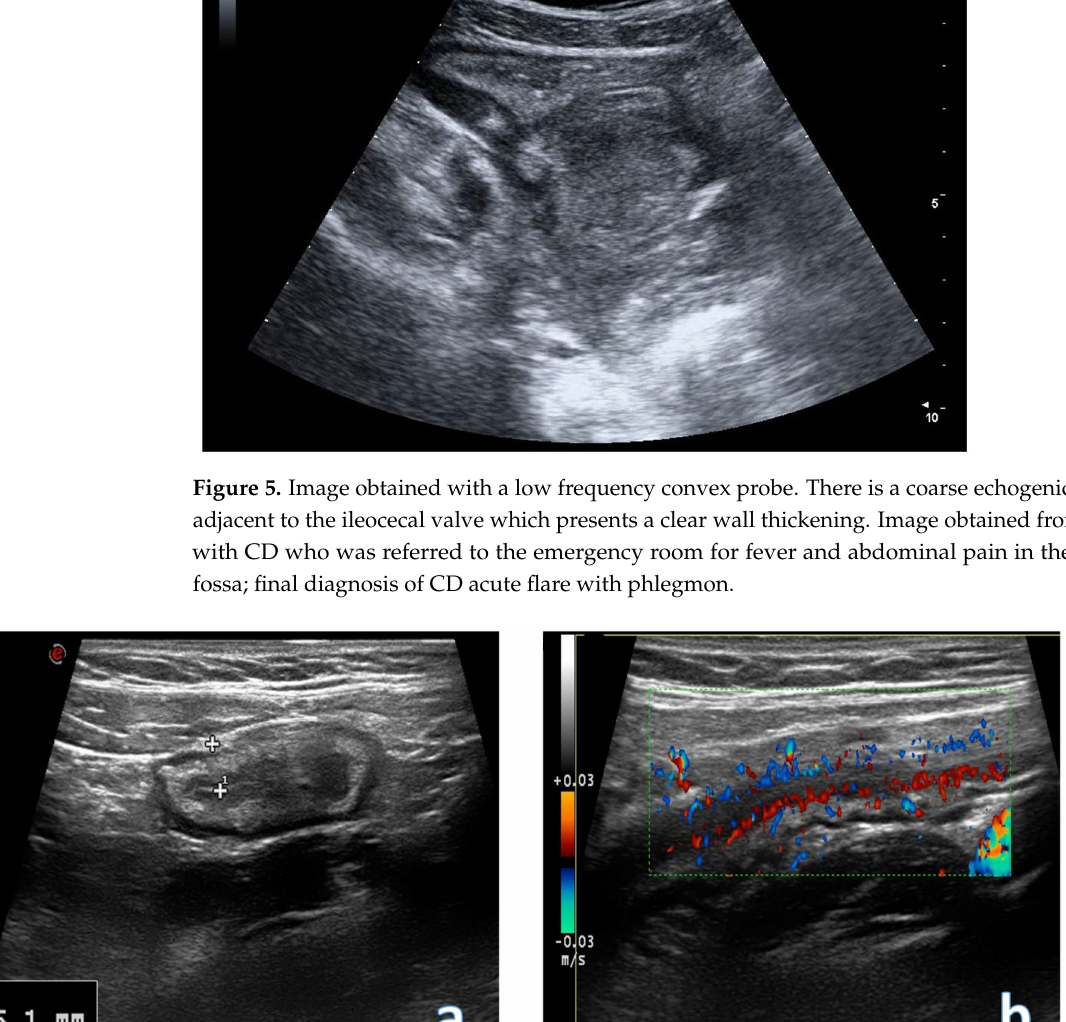
Figure 6. Images obtained with a high frequency linear probe. The image ( a ) shows a transversal scan of a section of colon with thickened walls (ulcerative colitis diagnosis); there is a hypertrophic feature of the submucosa layer. In image ( b ) the color function is inserted, which shows a hypervas ‐ cularization of the wall, compatible with acute ulcerative colitis flare.